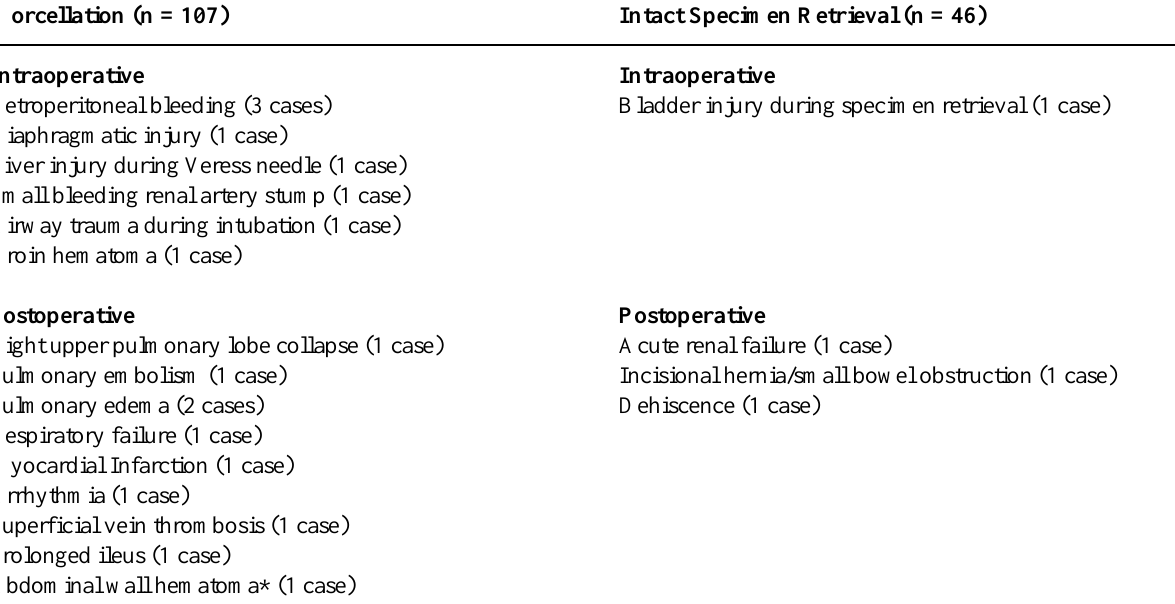
Table 3 – Intraoperative and postoperative complications in the morcellated and intact specimen retrieval